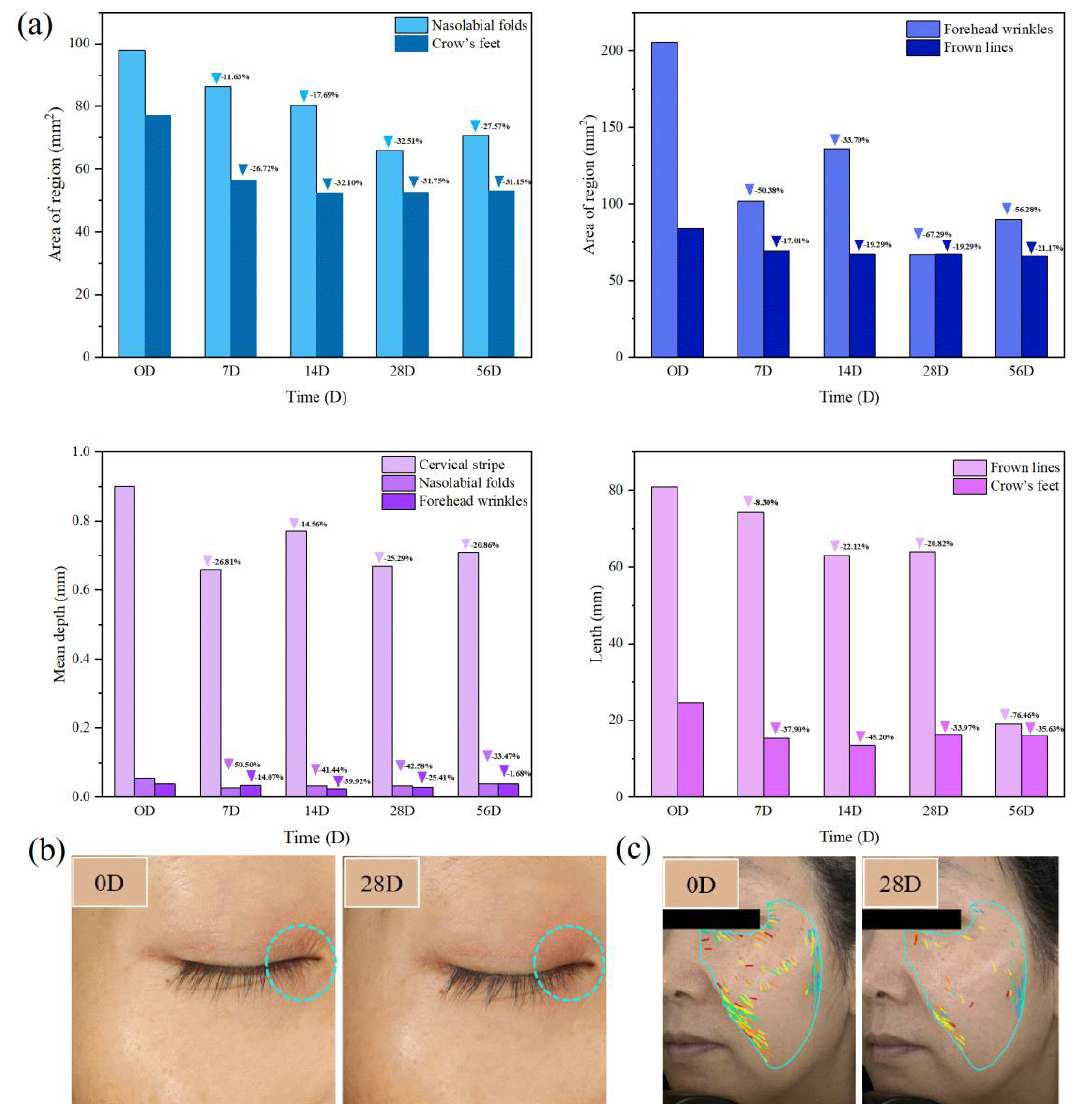
Figure 7. ( a ) Year-on-year changes in facial wrinkles after using Gravi − A nanoparticles for 56 days, where triangles/arrow heads represent the wrinkle area is gradually decreasing compared with 0 D. VISIA shows the anti-wrinkle effect of the control group and Gravi − A nanoparticles in humans after 28 days of treatment for ( b ) eye wrinkles and ( c ) facial wrinkles, respectively. The blue circle in Figure ( b ) indicates the obvious change area, and in Figure ( c ), light blue lines represent freckles, green lines represent wrinkles, red lines represent inflammation, and yellow lines represent porphyrins.